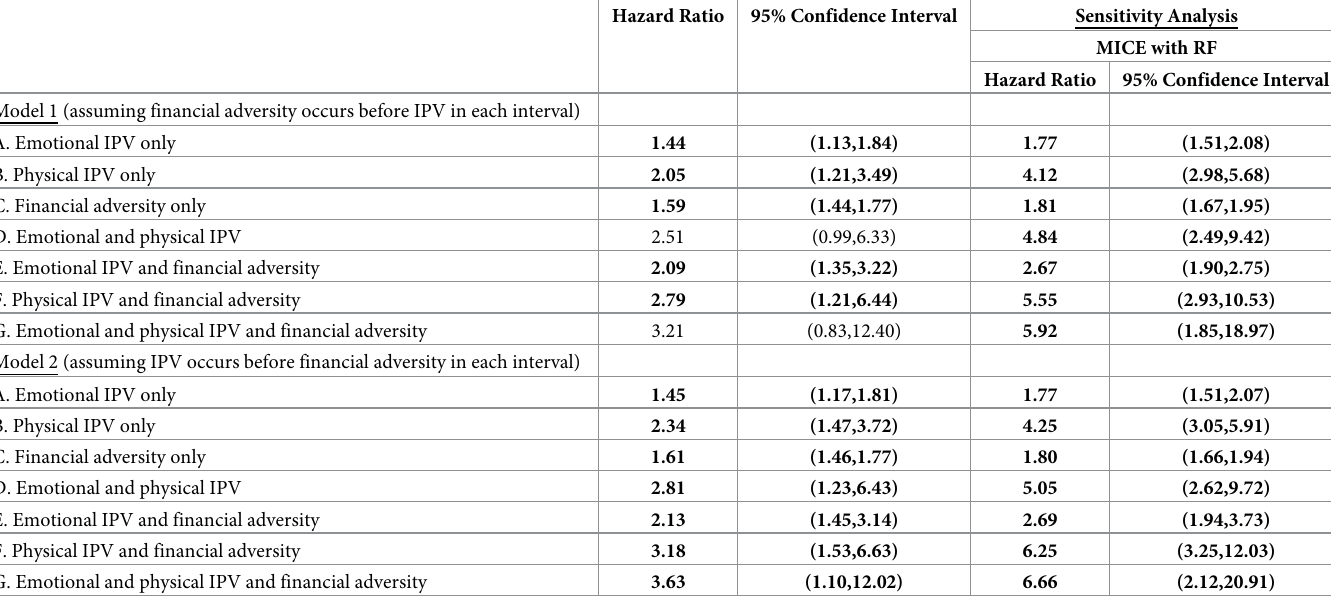
Table 2. Associations between emotional and physical IPV and financial adversity on